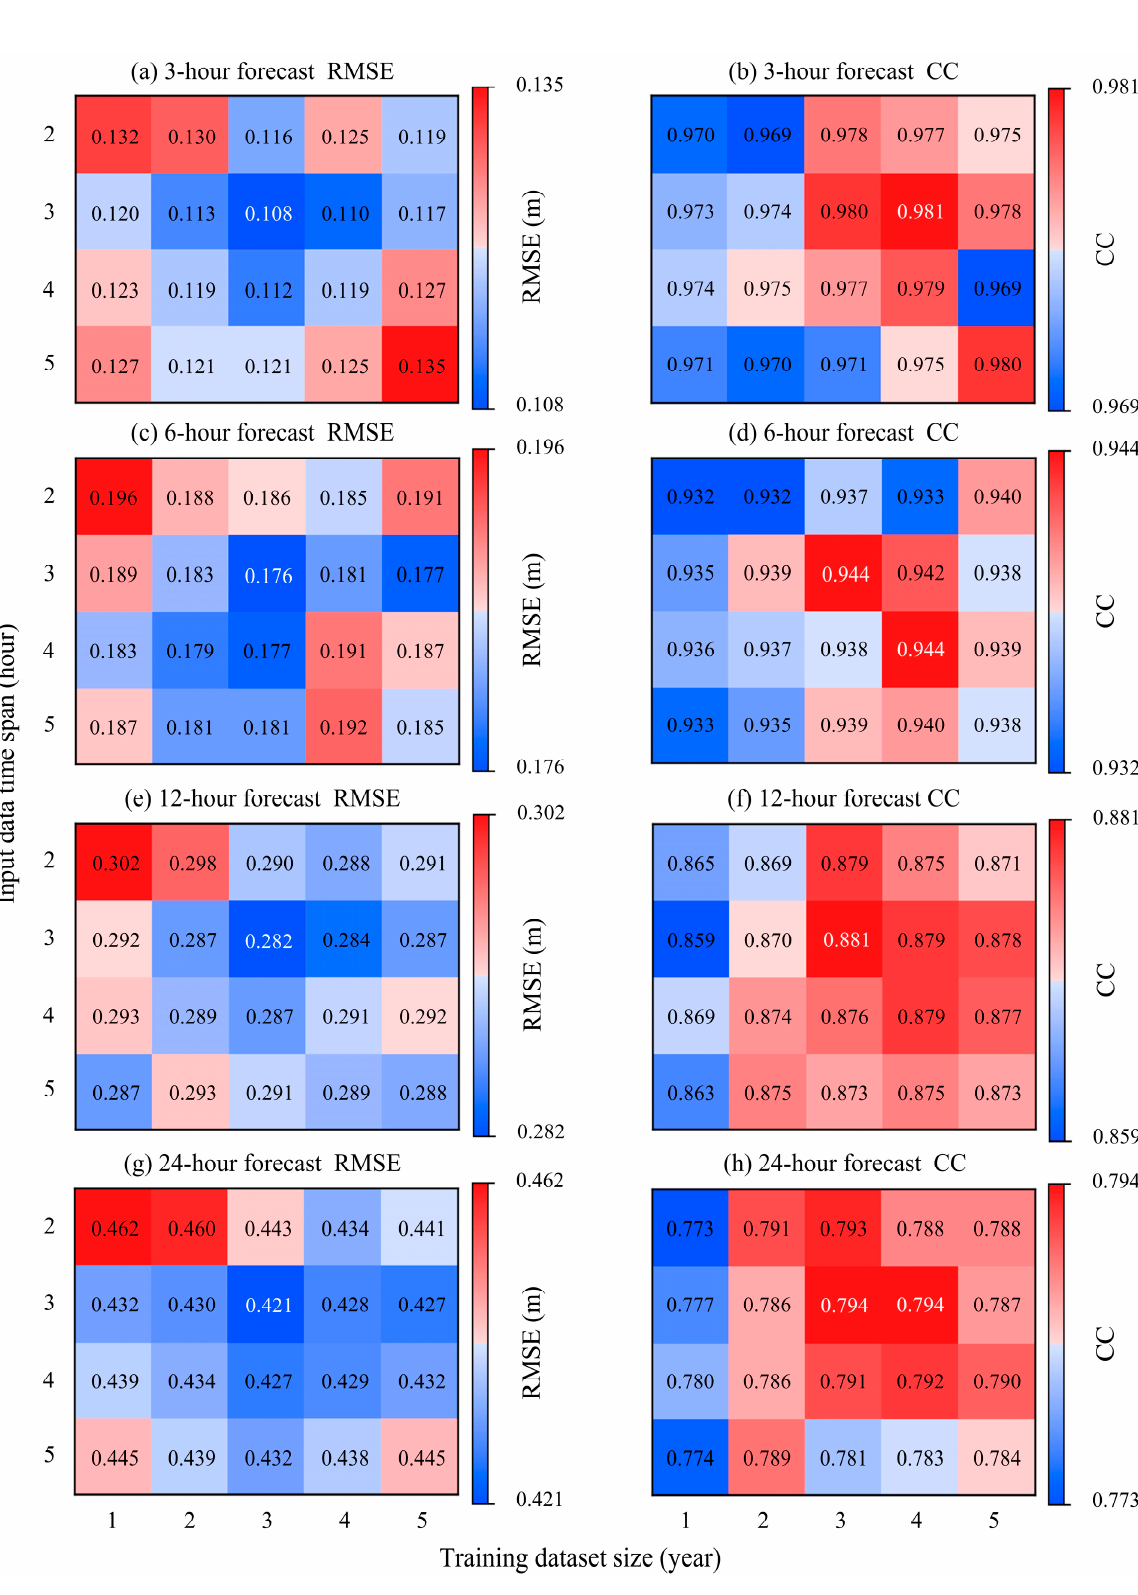
Figure 4. RMSE and CC of twenty sets of experiments at 3-, 6-, 12-, and 24-h for SWH forecasting on the test